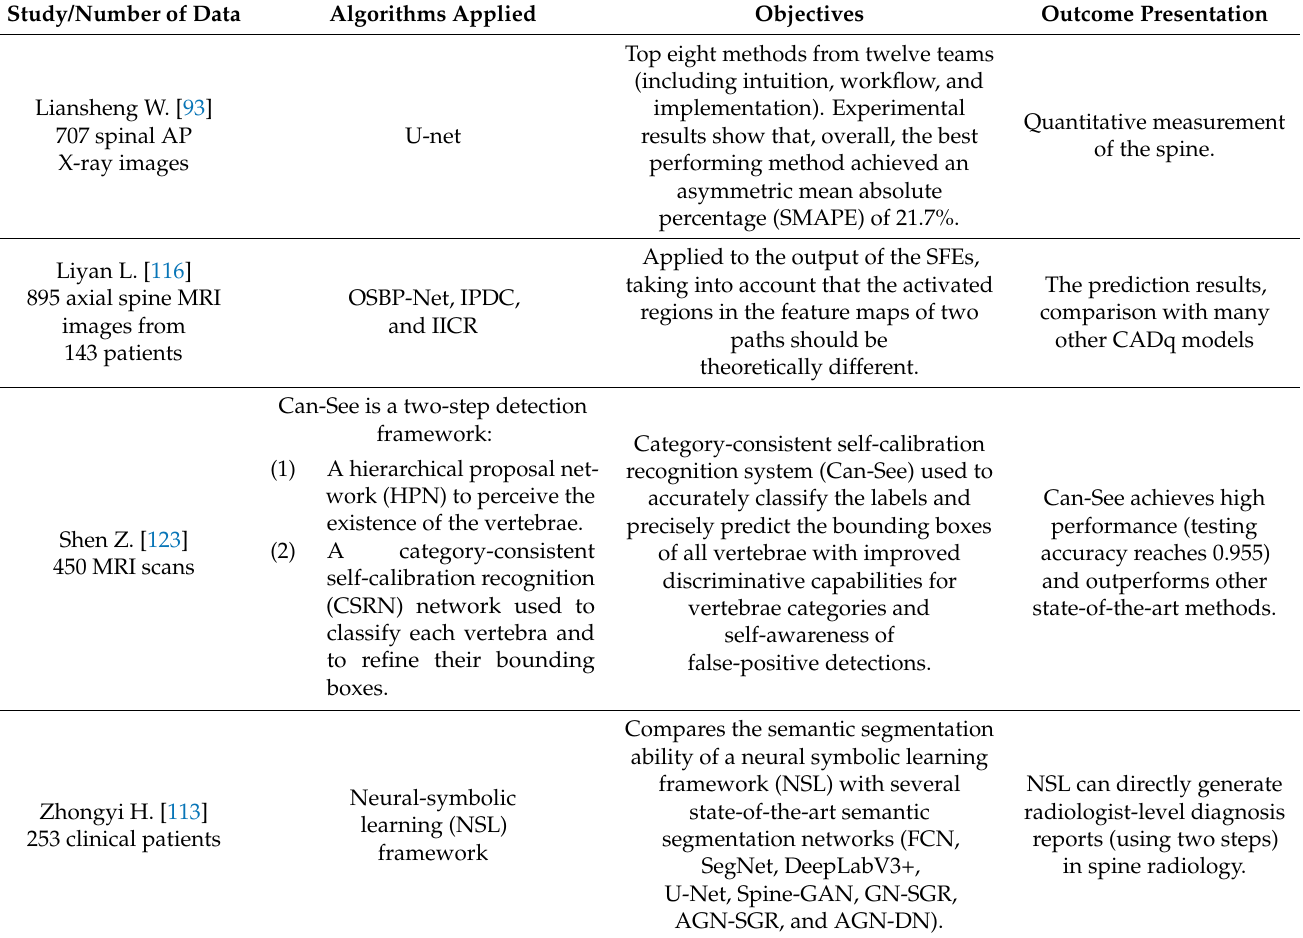
Table 1. Publications on spine image analysis based on “SpineWeb” (years